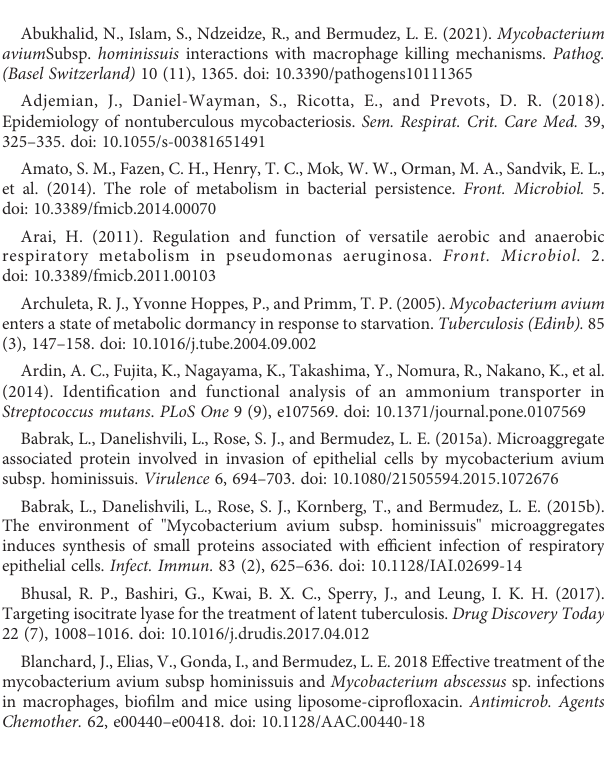
SUPPLEMENTAL 1 Proteins downregulated and proteins upregulated. SUPPLEMENTAL 2 Proteins Upregulated in different